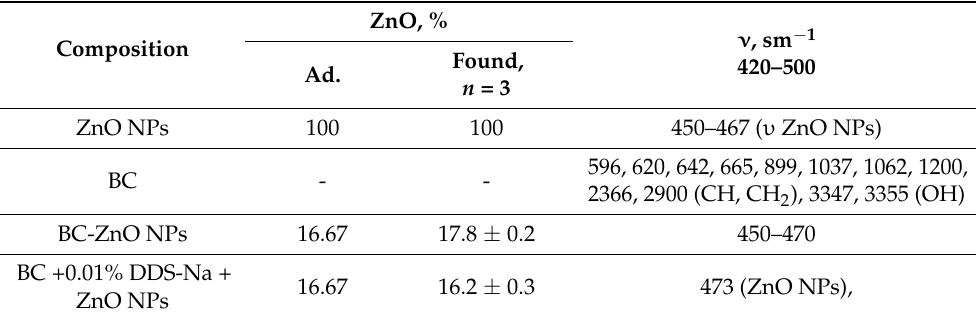
Table 6. Composition and FTIR spectral characteristics of ZnO NPs and bacterial cellulose samples (Figure S4).